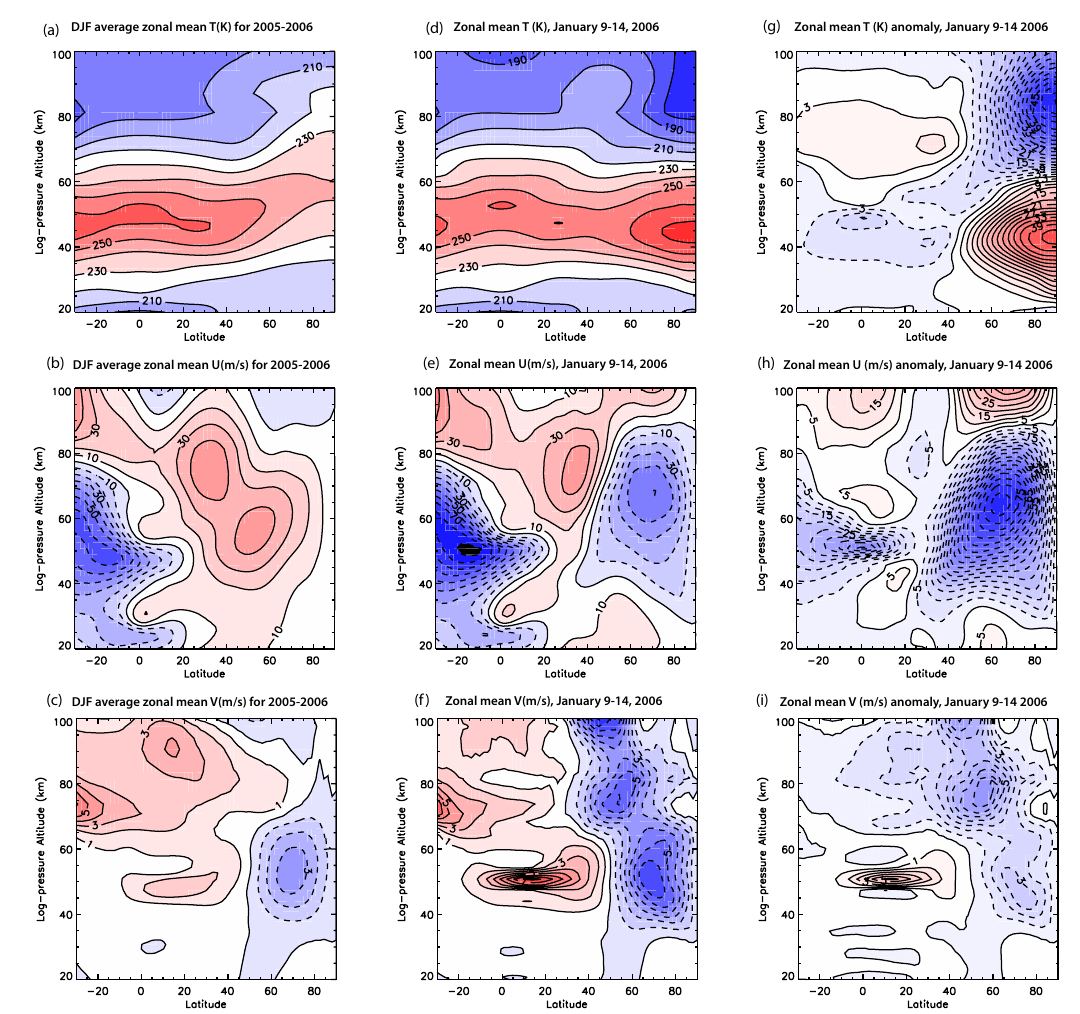
Figure 4. The seasonal average zonal-mean (a) temperature ( T ), (b) zonal wind ( U ) and (c) meridional wind ( V ) between December and February during the winter of 2005–2006, the zonal-mean (d) temperature (e) zonal wind and (f) meridional wind during 9–14 January days centered around 2006 SSW event and the zonal-mean anomalies as difference from climatological mean during the SSW event in (g) temperature (h) zonal wind and (i) meridional